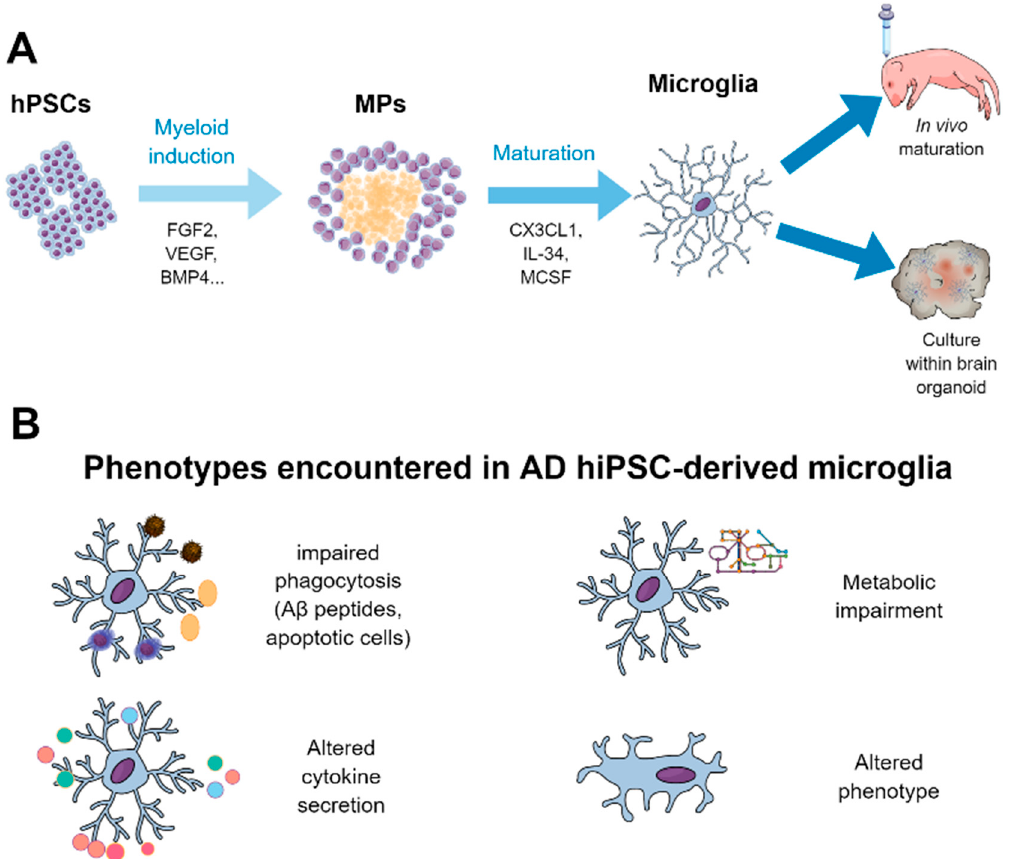
Figure 4. The most used protocol for the generation of microglia from hPSCs ( A ) and the main phenotypes encountered in microglia derived from iPSCs of AD patients ( B ). hPSCs: human pluripotent stem cells; iPSCs: induced pluripotent stem cells; bFGF: basic fibroblast growth factor; BMP4: Bone morphogenetic protein 4; VEGF: Vascular Endothelial Growth Factor; MCSF: Macrophage Colony Stimulating Factor; IL-34: interleukin 34; MPs: myeloid precursor cells; A β : amyloid beta; AD: Alzheimer’s disease.